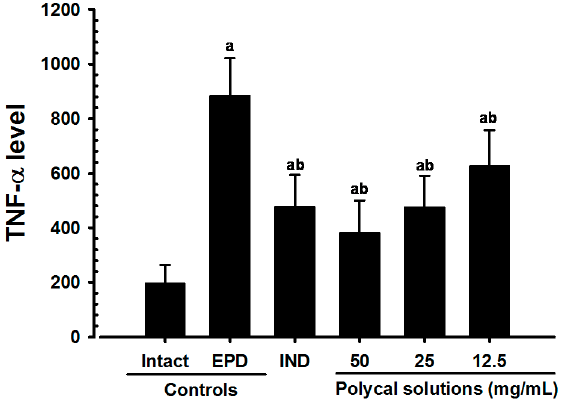
Figure 6. Gingival TNF- α Levels in Intact or EPD Rats. Values are expressed mean ± S.D. of eight rats, pg/mL. EPD = experimental periodontal diseases induced by ligature placement around the cervix of upper left incisor teeth; Polycal = Polycan and calcium gluconate 2:98 (g/g) mixture, which was topically applied to ligated gingival regions, once a day for 10 days (200 μ L/rats). IND = Indomethacin, which was orally administered at 5 mg/kg dose level, once a day for 10 days; TNF = Tumor necrosis factor. a p < 0.01 as compared with Intact control; b p < 0.01 as compared with EPD control.